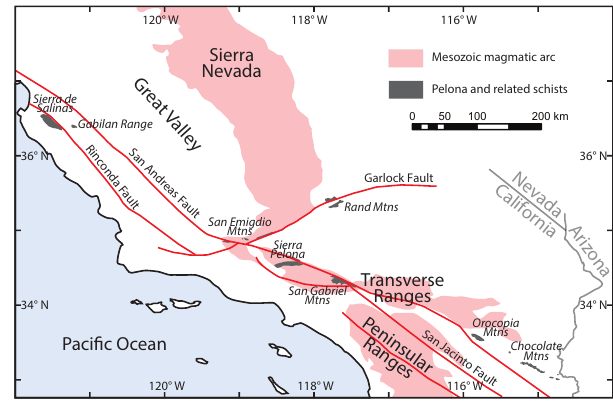
Figure 1. Regional tectonic map of southern California showing outcrops of Laramide subduction related schists, Mesozoic mag- matic arc, and major faults. Modified from Jennings